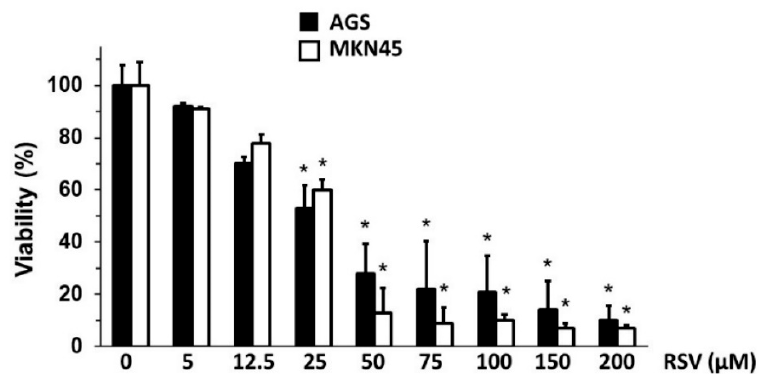
Figure 1. Effect of RSV treatment on cell viability of gastric cancer cell lines. AGS and MKN45 gastric cancer cells were treated with different concentrations of RSV (5–200 µ M) for 24 h. Cell viability was determined using the SRB dye assay. Bars represent the percentage of viability in AGS (black bar) and MKN45 (white bar) cells in a dose-dependent manner compared to the control ethanol-treated cells (control 100% viability). Values represent means ± S.D. of four independent experiments. (* p < 0.05).